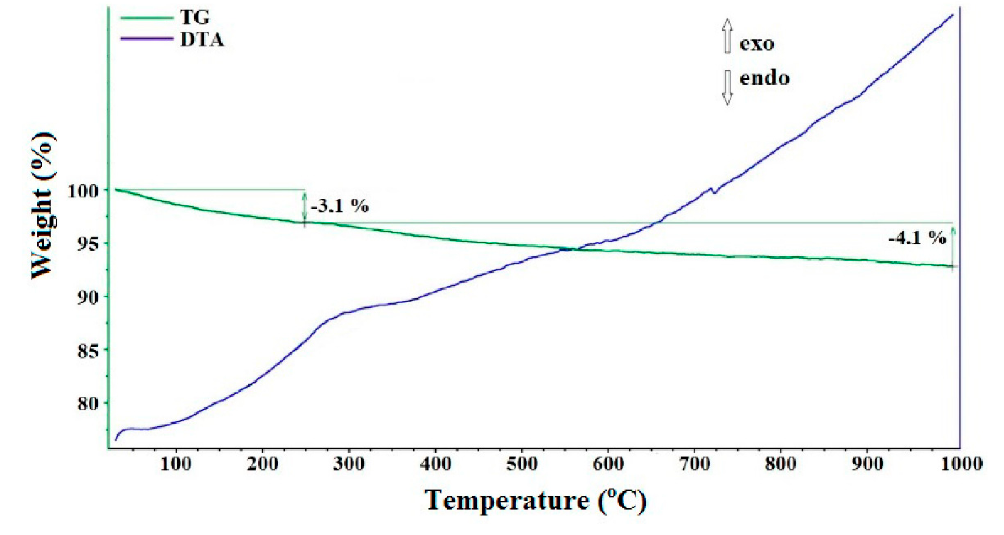
Figure 4. DTA and TG curves for sample 2 .